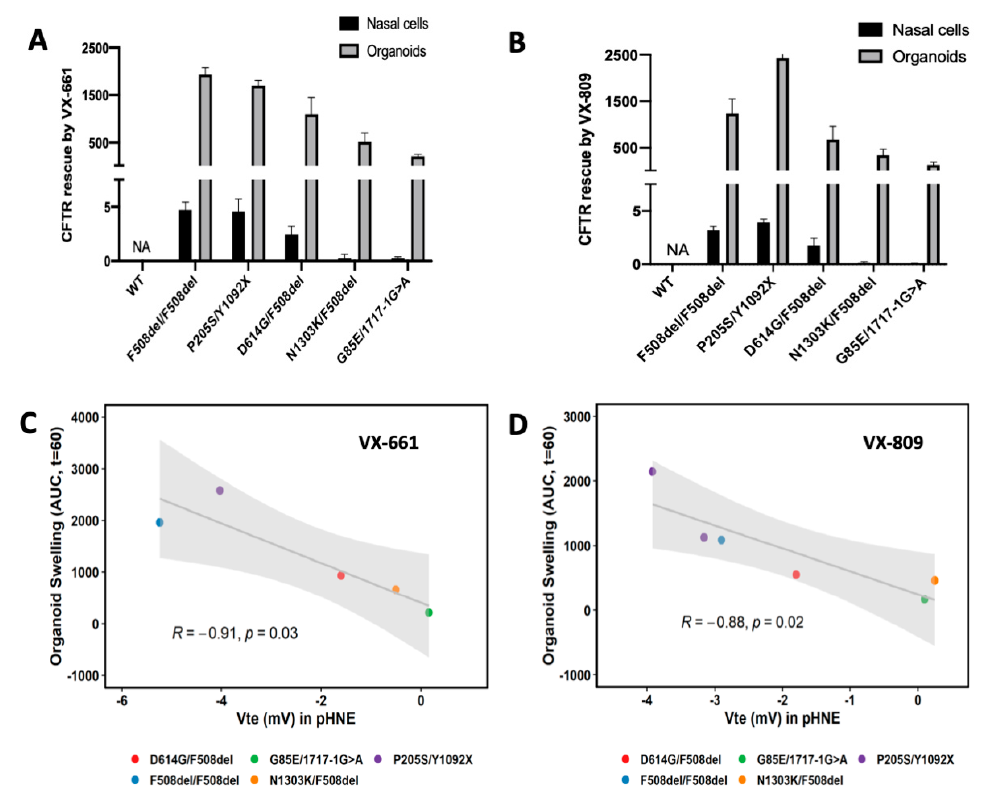
Figure 4. Correlation between CFTR rescue by CFTR modulators in pHNEs and intestinal organoids. ( A , B ) Summary of responses in intestinal organoids (shown as ∆ AUC (DMSO-treated) t = 60, 3 µ M VX-809 or 5 µ M VX-661) and pHNE cells (shown as transepithelial voltage (Vte)) in five different individuals. WT function in intestinal organoids is not comparable due to pre-swelling (due to CFTR pre-activation by endogenous cAMP). According to standard protocols, pHNEs were treated with DMSO, 3 μ M VX-809, or 5 μ M VX-661 for 48 h and intestinal organoids for 24 h. Data is represented as the mean of three technical replicates for each model ± SD. ( C , D ) Correlation analysis of CFTR rescue in pHNEs and intestinal organoids from the same individual (Pearson’s R = − 0.91, p -value = 0.03 for VX-661 and Pearson’s R = − 0.88, p -value = 0.02 for VX-809). The grey line represents the linear regression of the data. The grey area represents the 95% confidence interval.